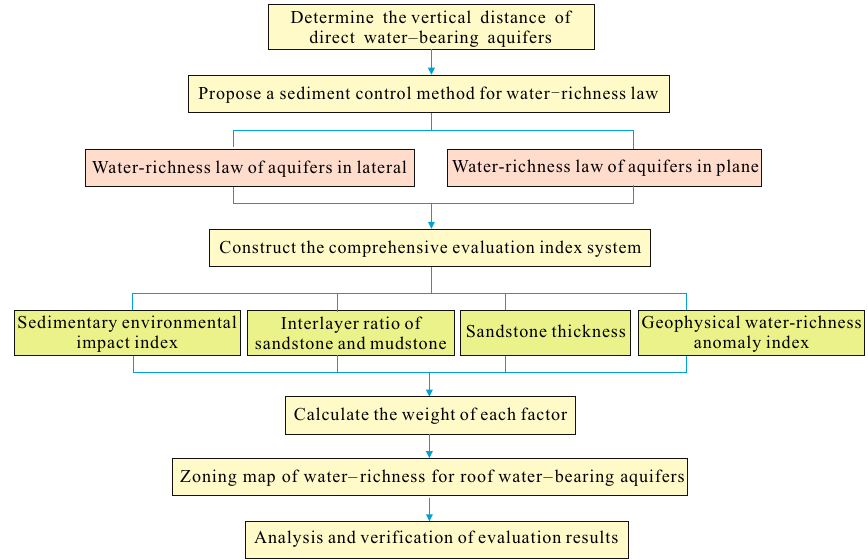
Figure 3. Flowchart of the methodology used in this study.